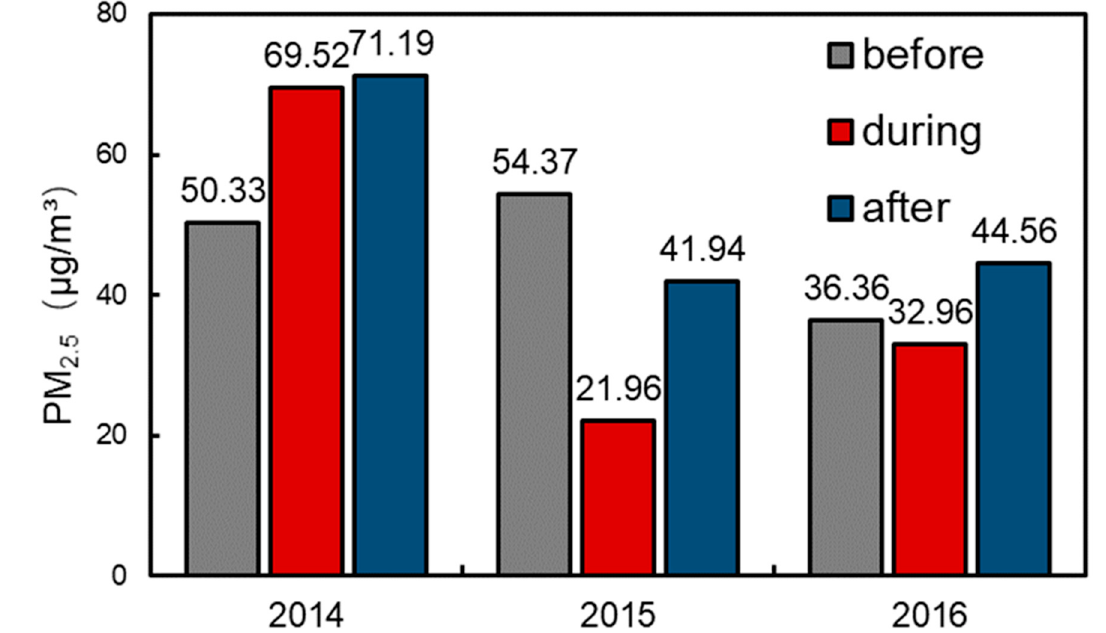
Figure 12. PM 2 . 5 average concentration in three periods in 2014, 2015, and 2016. The averaged time periods in 2014 and 2016 are both in consistent with 2015 as demonstrated in previous sessions.